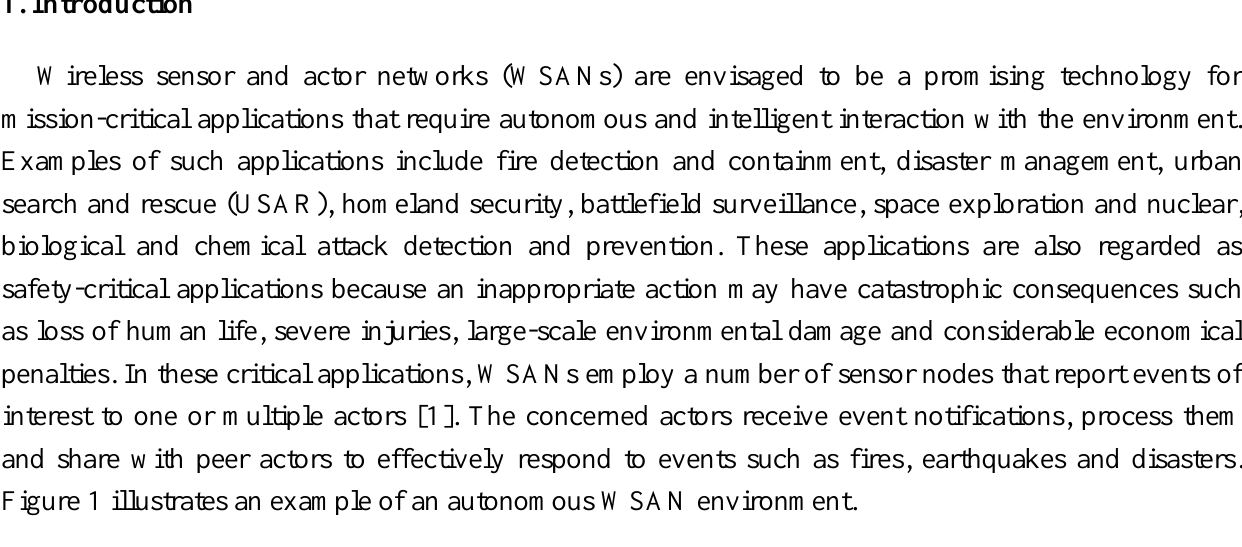
Figure 1. An example of autonomous wireless sensor and actor network